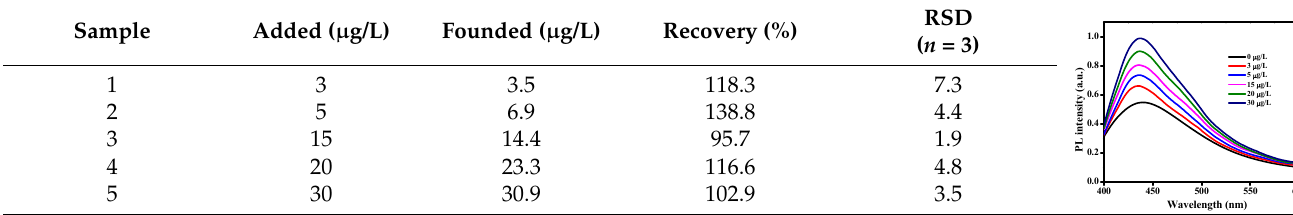
Table 2. Detection of MFH in human serum.